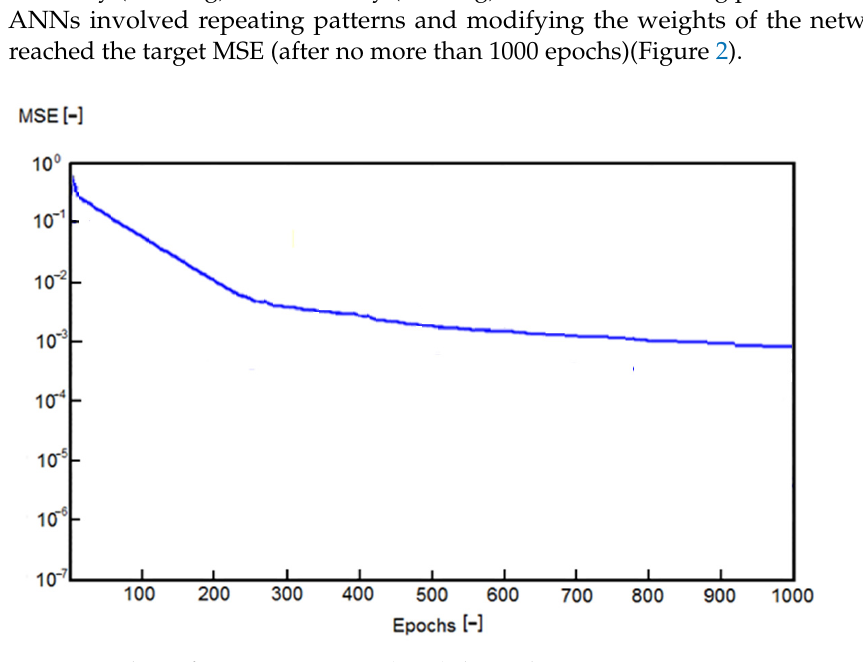
Figure 2. Values of mean square error (MSE) during learning.